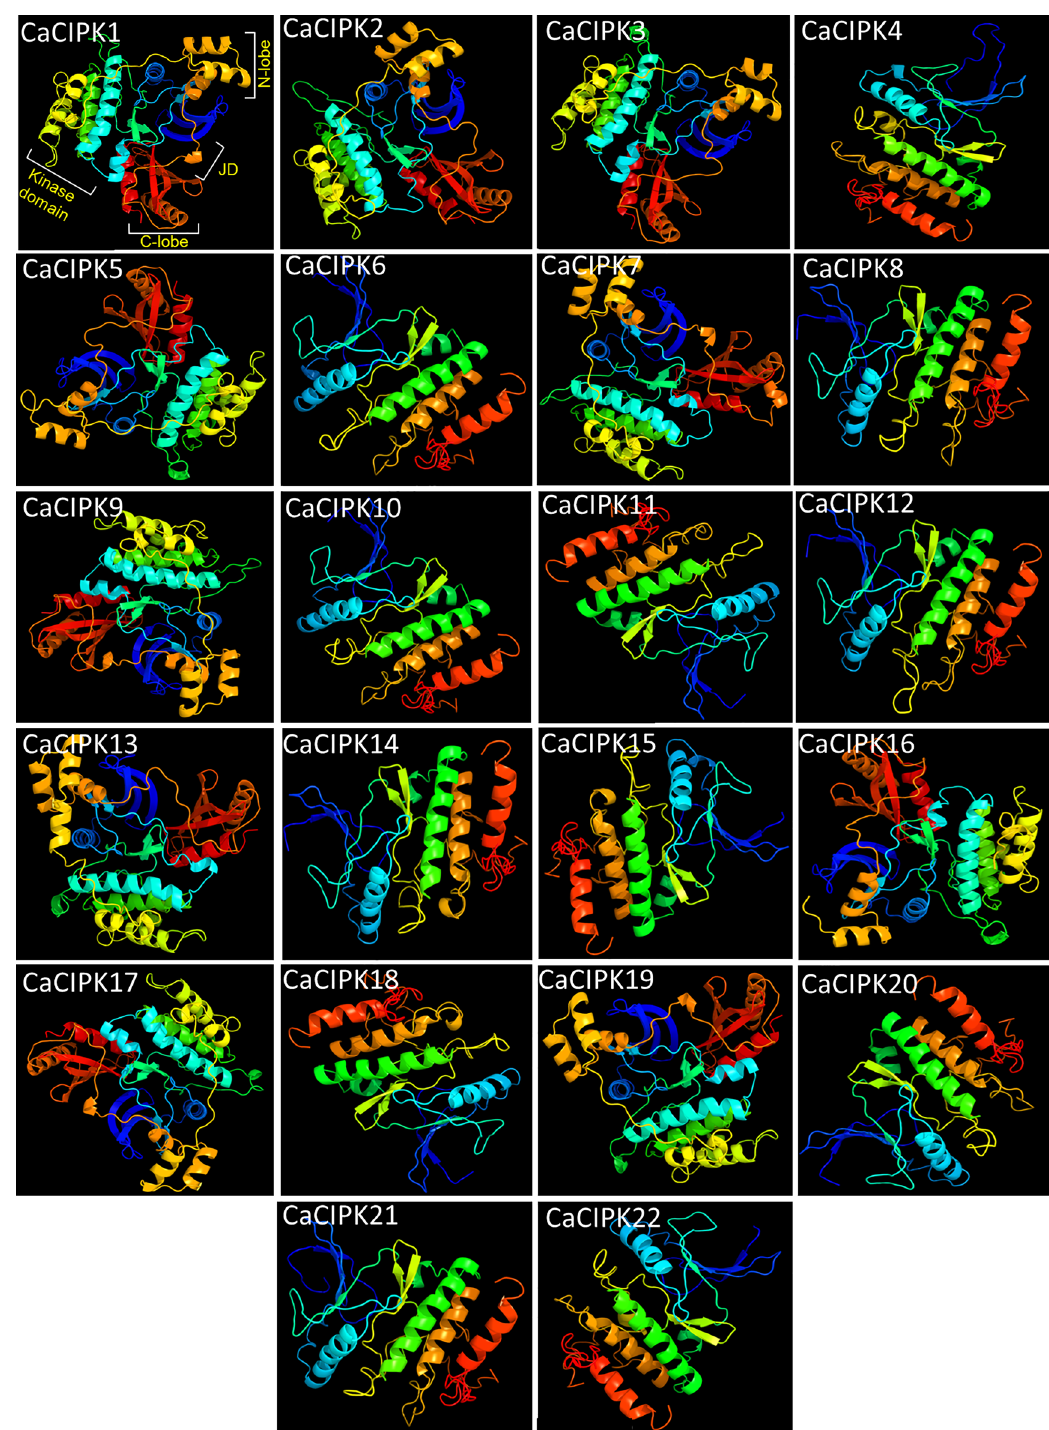
Figure 6. Three-dimensional structure of chickpea CIPK proteins. 3-D structure was generated for all 22 members of chickpea CIPK family using PHYRE2. Each CIPK protein is made up of variable number of α-helix, β-strands, transmembrane helix and disordered